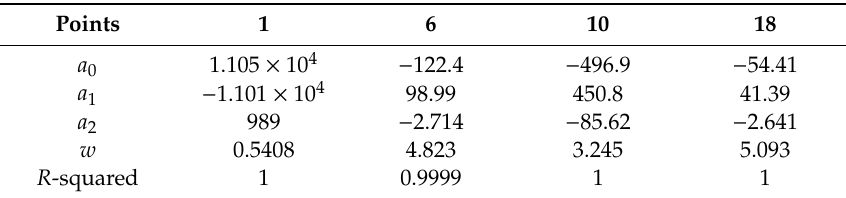
Table 3. Fitting coe ffi